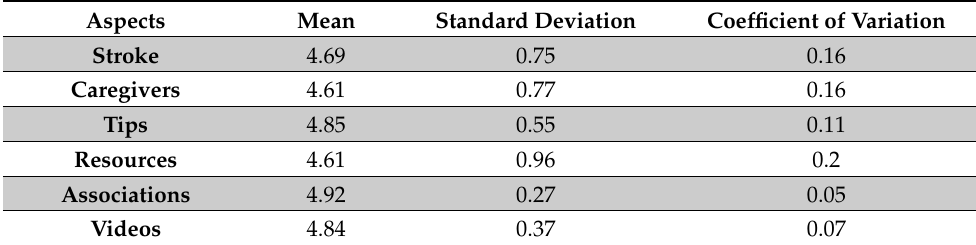
Table 5. Statistical results of the first round.